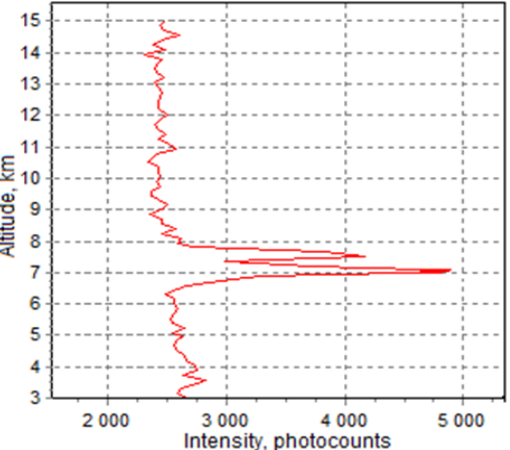
Figure 3. Vertical profile of the lidar signal intensity (6 January 2021; series of measurements was performed from 2:34 to 2:51 p.m.). Table 1. Geometric and optical characteristics of the cloud registered in lidar measurements (6 January 2021; series of measurements was performed from 2:34 to 2:51 p.m.). Border Altitudes,